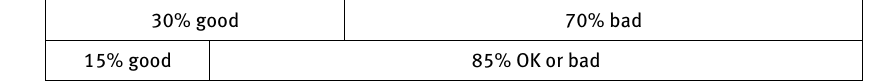
Fig. 1: Polarized distribution of Dutch sailors